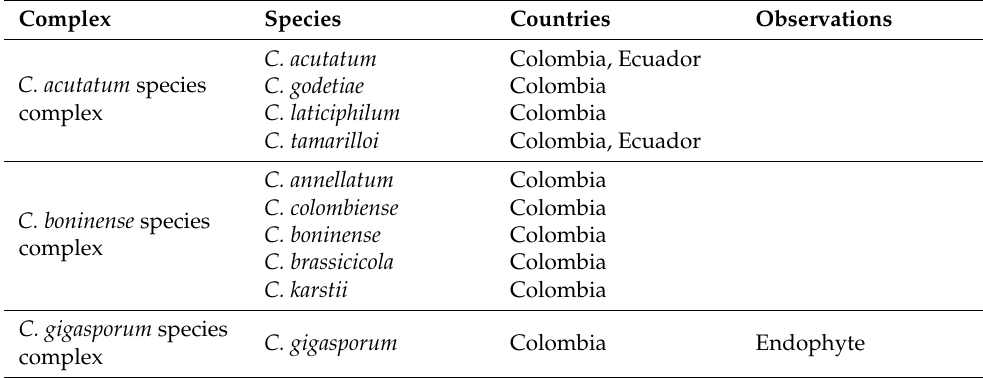
Table 1. Colletotrichum species reported in Colombia, Ecuador, Peru, and Venezuela. Complex